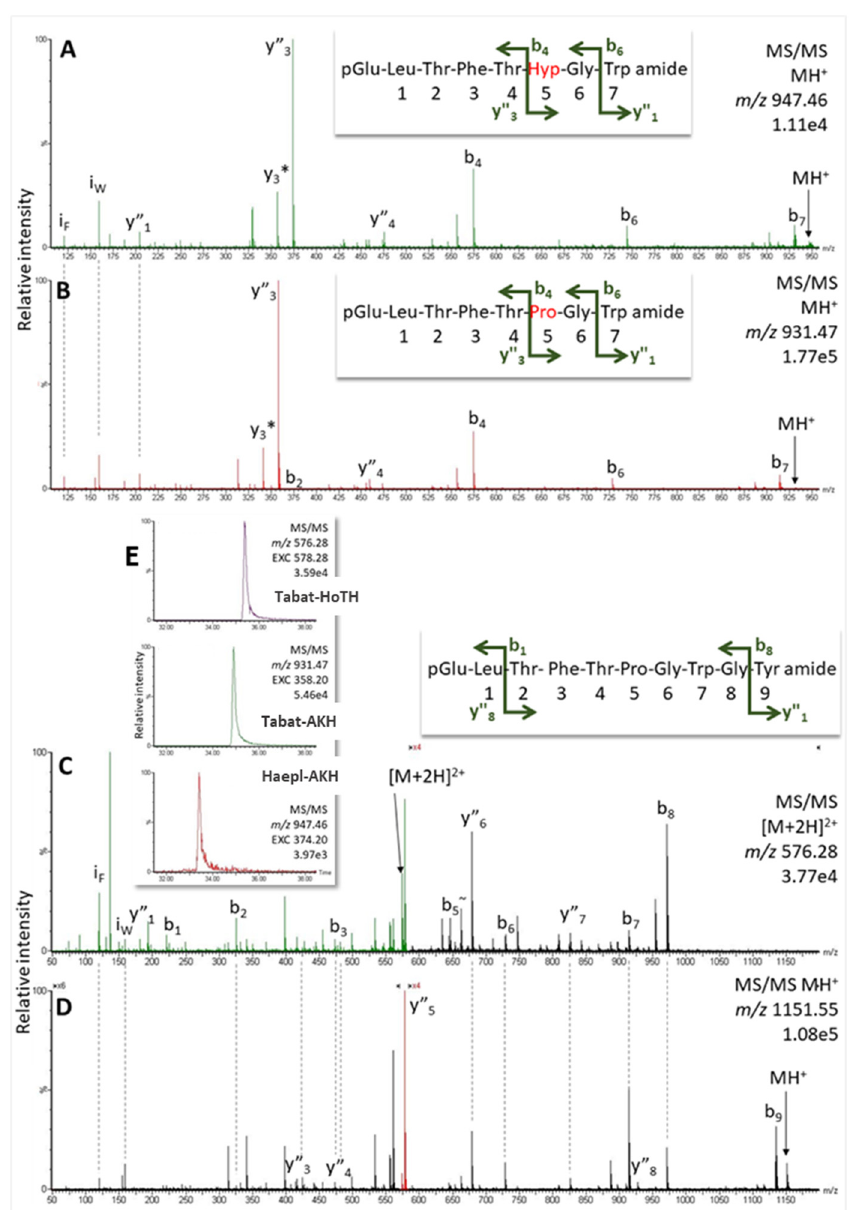
Figure 5. MS analysis for AKHs in H. pluvialis (1 µ L injection, equivalent to the glandular content